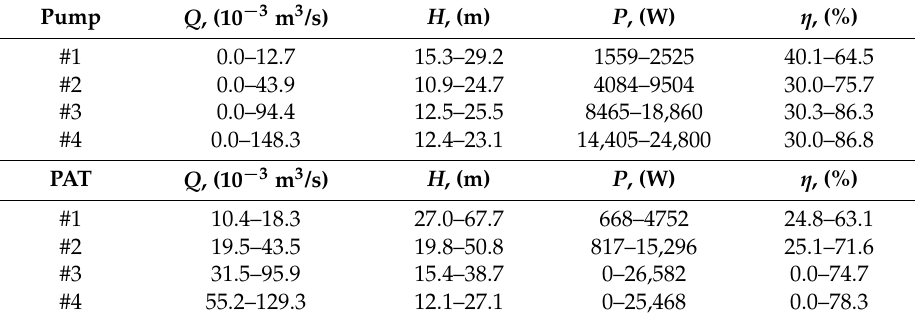
Table 2. Pump and pumps used as turbines (PAT) operating range reported in